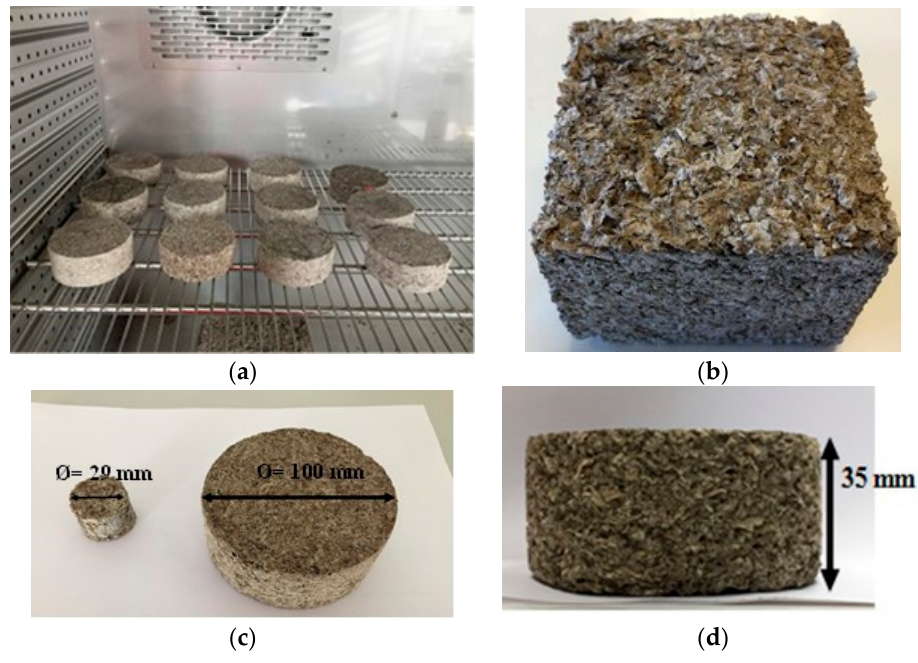
Figure 4. Composite specimens obtained from the four formulations. ( a ) Cylindrical samples; ( b ) Cubical samples; ( c , d ) Samples for acoustical test.